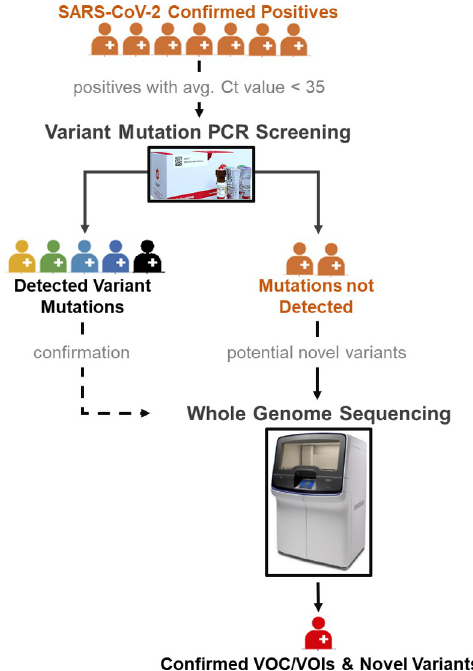
Fig 6. Proposed algorithm for SARS-CoV-2 variants detection and characterization using multiplex genotyping PCR and genomic sequencing assays. Confirmed SARS-CoV-2 positives are first screened by Variant genotyping PCR. Samples with detected variant mutations can be confirmed by whole genome sequencing for precise variant classification as needed. Samples for which variant mutations are not detected should be analysed by whole genome sequencing to assess possibility of emerging novel